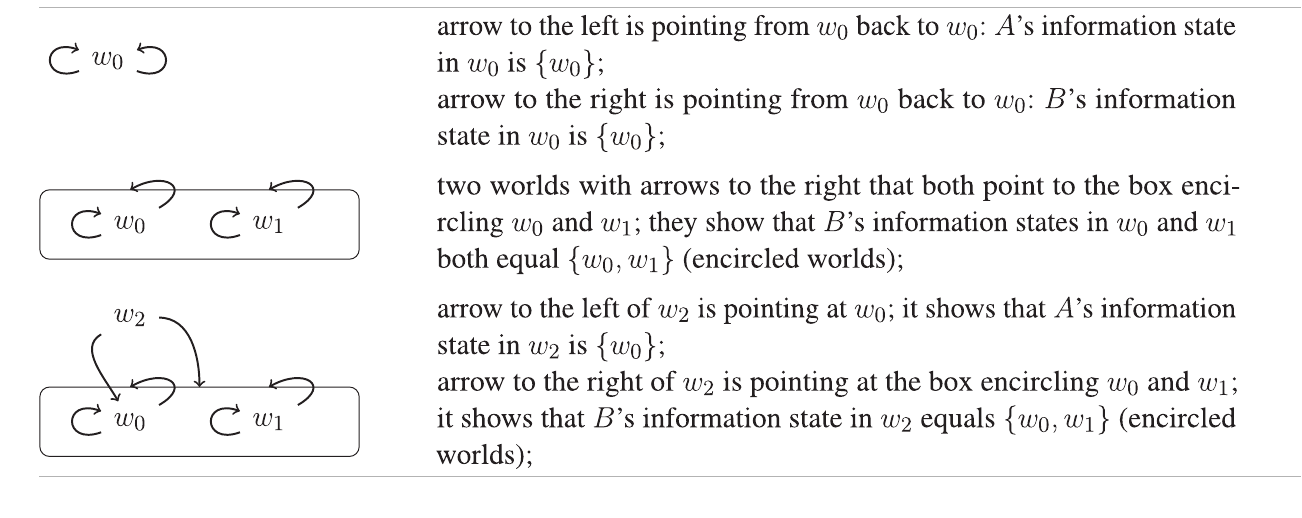
TABLE 14 | Reading epistemic graphs. The comments to the right explain new features of the respective graphs.